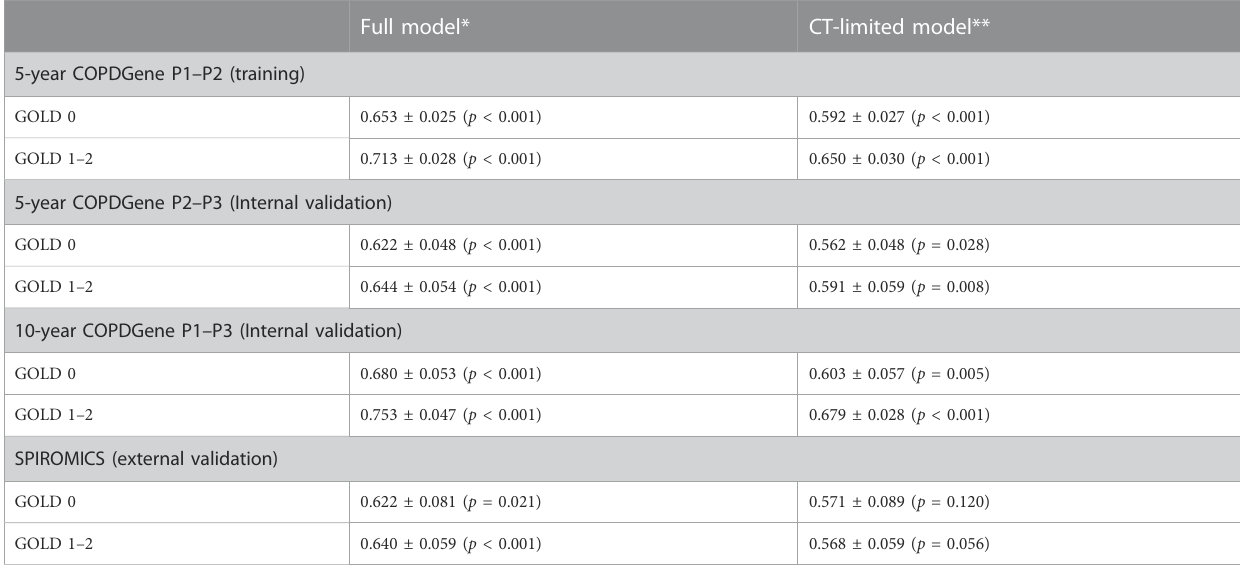
TABLE 3 Cross-validation AUCs, listed as mean ± 1.96 standard deviation